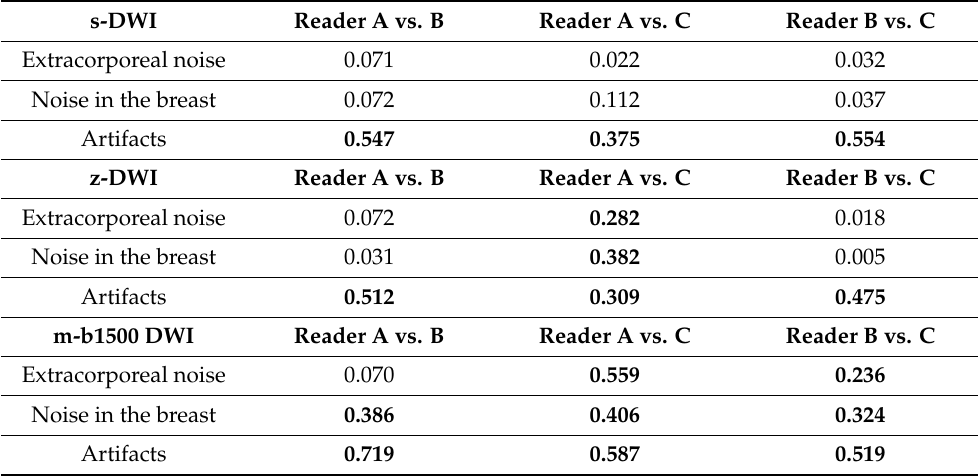
Table 4. Pairwise reader reliability (Cohen’s kappa) for each sequence. A kappa value of > 0.21 was considered sufficient (marked in